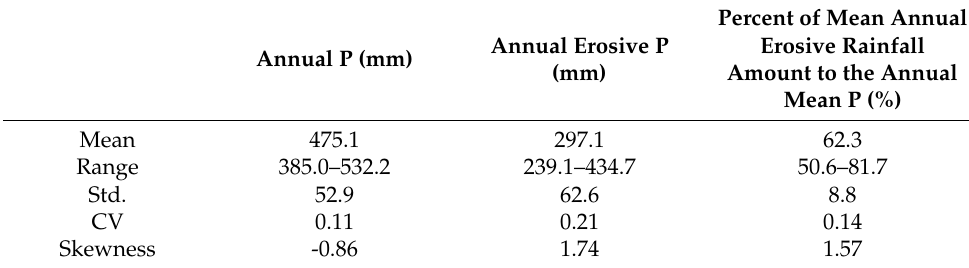
Figure 2. Annual erosive and non-erosive rainfall and the percentages of erosive rainfall amounts in 2014–2020. Table 2. Statistical characteristics of annual (erosive) rainfall and the percent of erosive to total rainfall amount in 2014–2020.